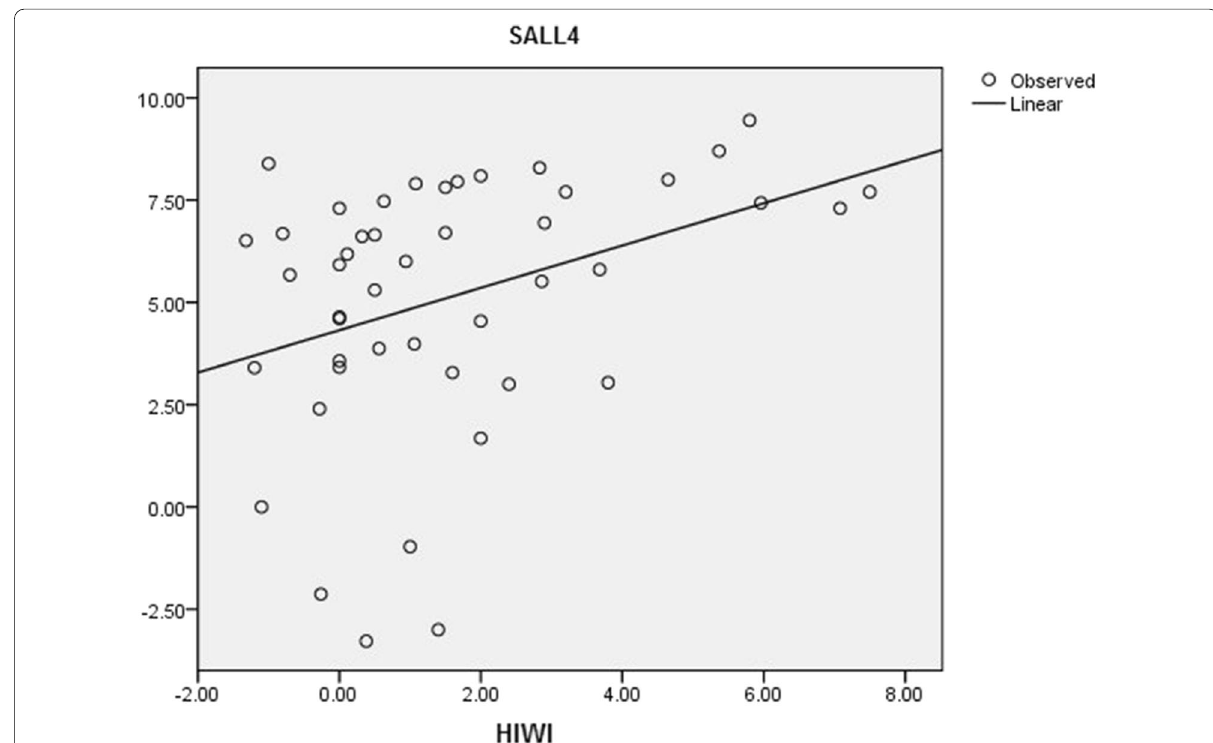
Fig. 2 Regression plot presents the correlation between expression of SALL4 and HIWI genes in CRC ( P Correlation between SALL4 and HIWI genes as significant in non-metastatic samples ( p the level of SALL4 and HIWI gene expression,